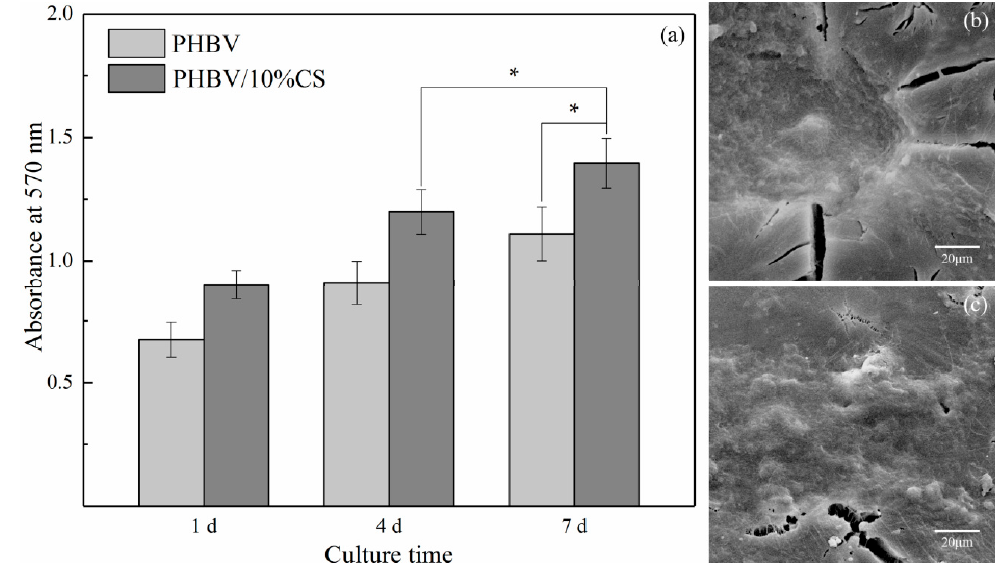
Figure 9. ( a ) The proliferation of MG63 cells cultured on the PHBV and PHBV/10% composite scaffolds (* represents p < 0.05); the SEM morphologies of MG63 cells cultured on the ( b ) PHBV and ( c ) PHBV/10% composite scaffolds on day 4.